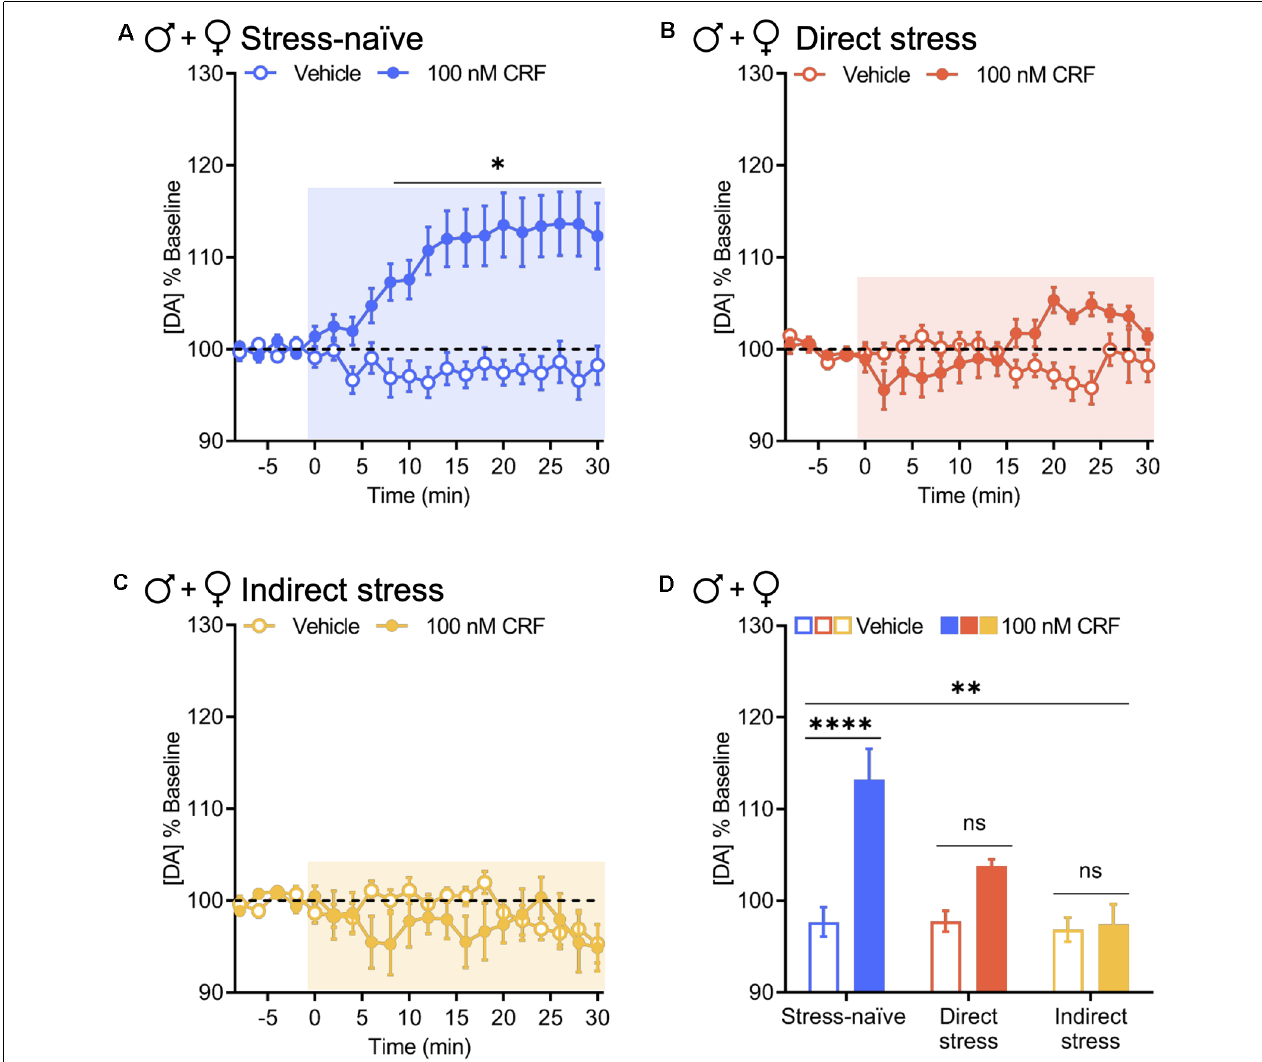
FIGURE 4 | Direct and indirect stress disrupt CRF-mediated dopamine release in the NAc 1 week after stress exposure. Baseline-normalized mean peak amplitude of electrically evoked dopamine release over time in response to vehicle or 100 nM CRF application to NAc slices collected from panel (A) stress-naïve males and females (vehicle and 100 nM CRF: n = 19); (B) directly stressed males and females 1 week after rFSS exposure (vehicle and 100 nM CRF: n = 10); and (C) indirectly stressed males and females 1 week after cage mates were subjected to direct stress (vehicle: n = 12, 100 nM CRF: n = 11). (D) Baseline-normalized mean peak amplitude of dopamine release 20–30 min after vehicle or 100 nM CRF application to NAc slices from stress-naïve (vehicle and 100 nM CRF: n = 19), directly stressed (vehicle and 100 nM CRF: n = 10), or indirectly stressed (vehicle: n = 12, 100 nM CRF: n = 11) males and females. Error bars, SEM. ns: P >